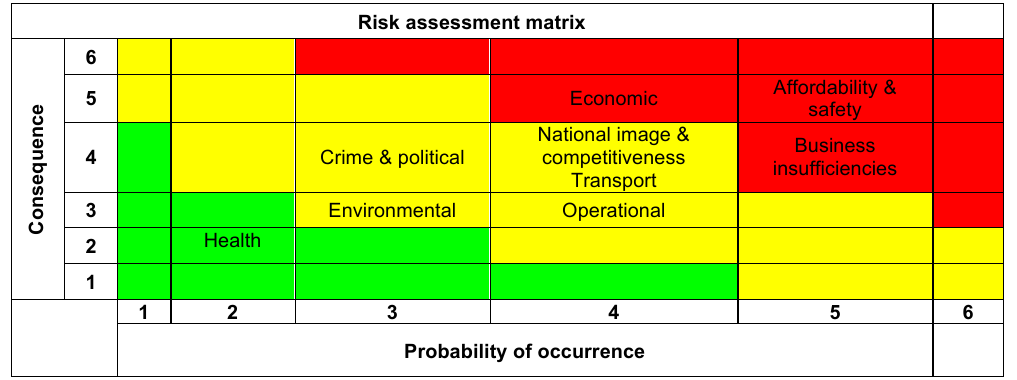
Risk assessment matrix for travel agents